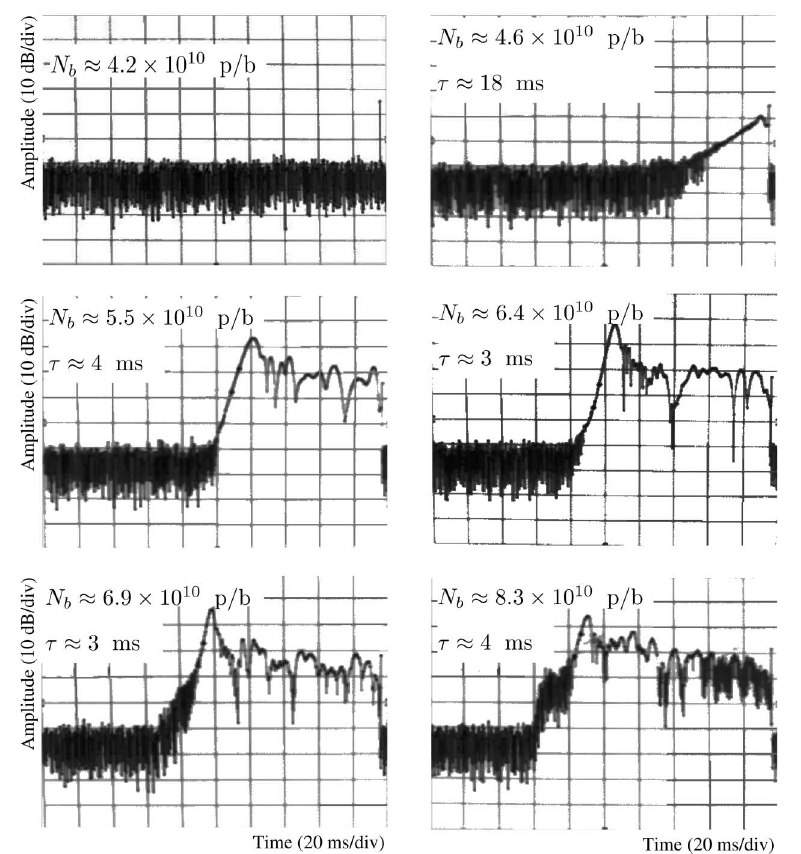
FIG. 10. Rise time of the horizontal instability as a function of the bunch intensity. The signal is obtained with a spectrum analyzer with zero frequency span and a central frequency 357 kHz. The beam is extracted at the end of the horizontal scale.